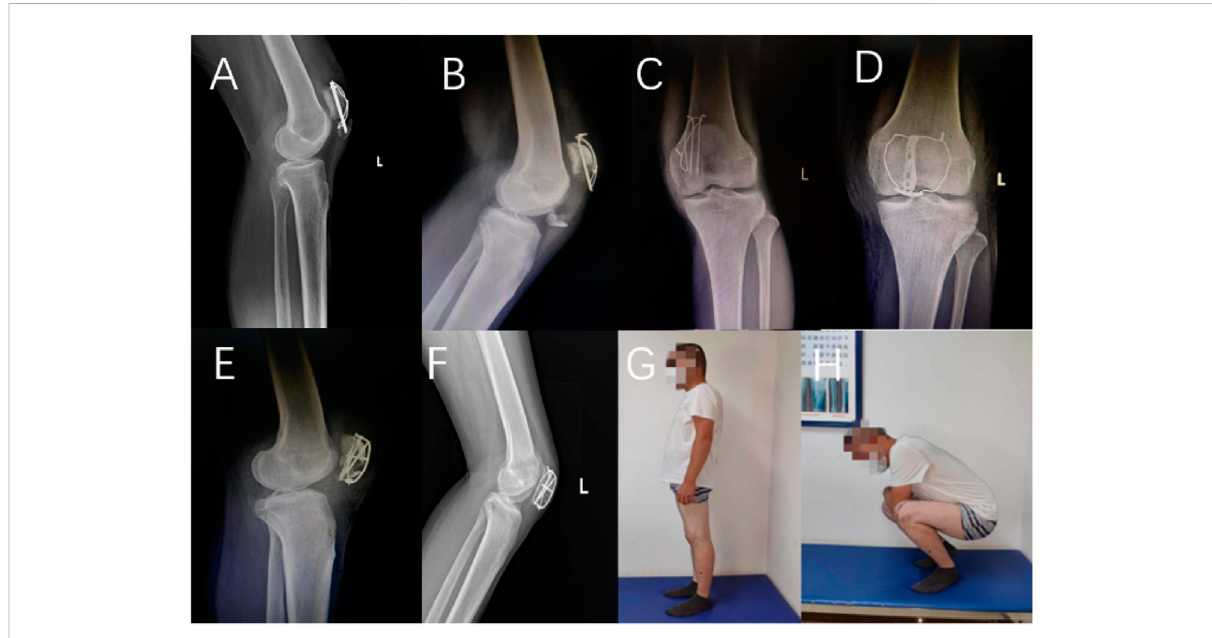
FIGURE 7 A 66-year-old female patient underwent tension band fi xation for two months after the review results (A) , and a 29-year-old male patient underwent tension band fi xation for one month after the review results (B,C) . The above female patient chose partial patellar resection and patellar ligament reconstruction surgery, and the above male patient chose to use the ALP for secondary fi xation. Twodays after thereview results (D,E) and three months after the review results (F) . At 9 months after operation, the knee joint function had recovered well (G,H)